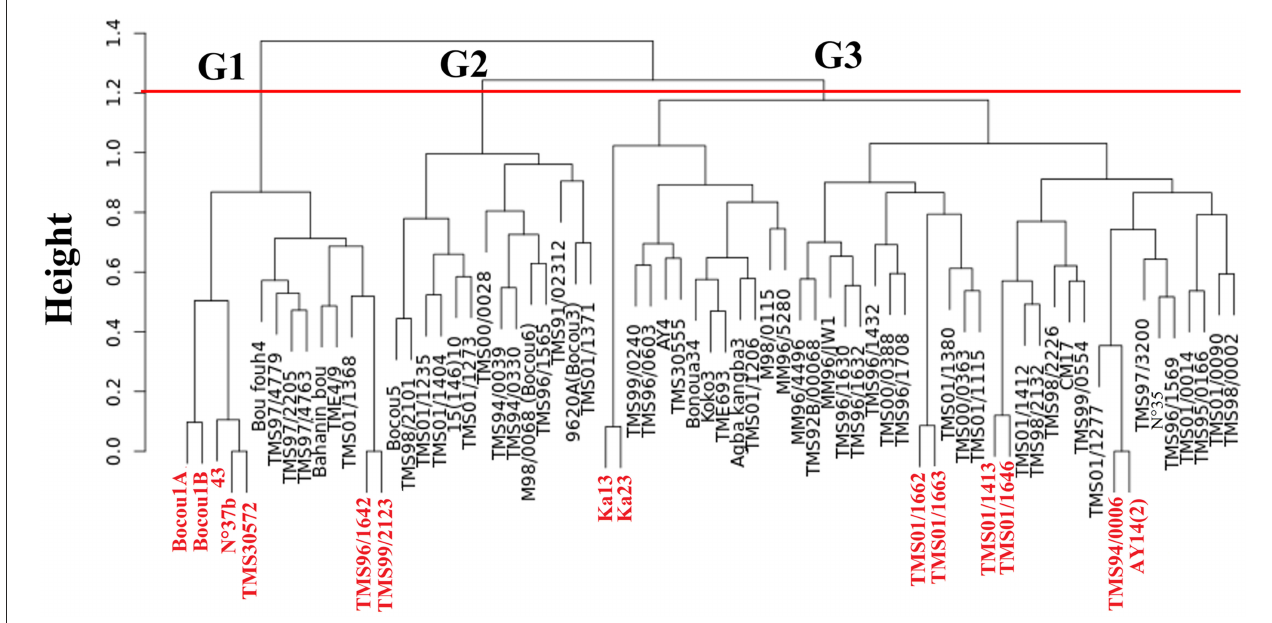
FIGURE6 Dendrogram realized using Ward’s minimum variance method showing the hierarchical clustering of the 69 cassava accessions revealing three groups (G1, G2, and G3). Accessions in red represent the 13 potential duplicates and those in black represent the 56 unique accessions.